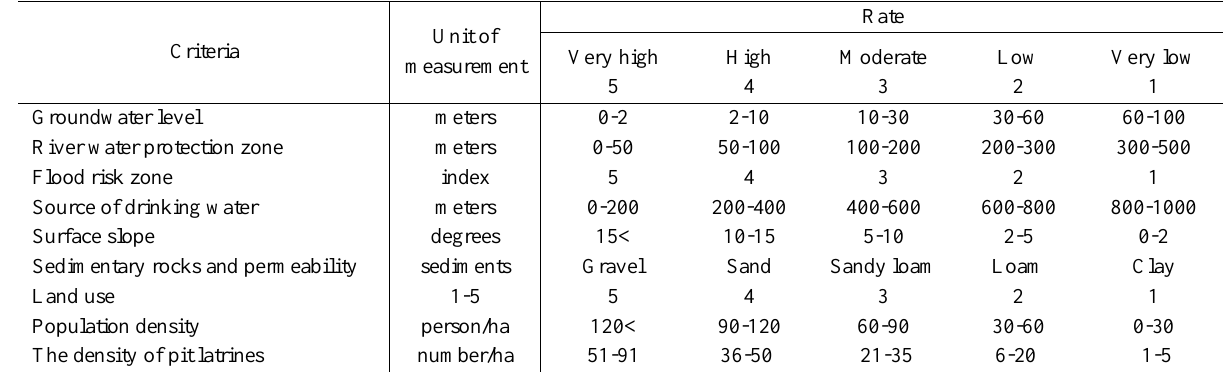
Table 2. Assessment of multi-criteria of environmental and human health effects of pit